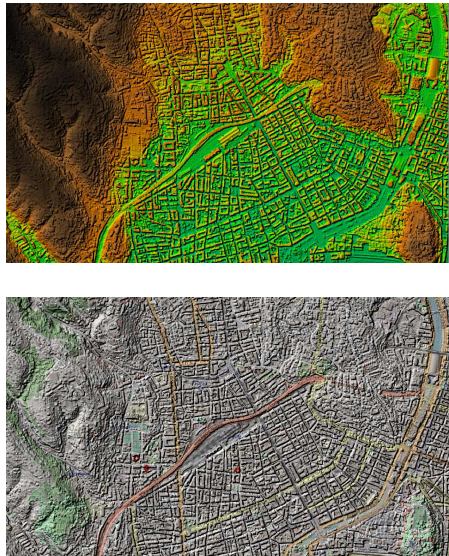
Figure 7: DSM overview of Nice (raw and mapped on Open Streep Map) generated in unit tests